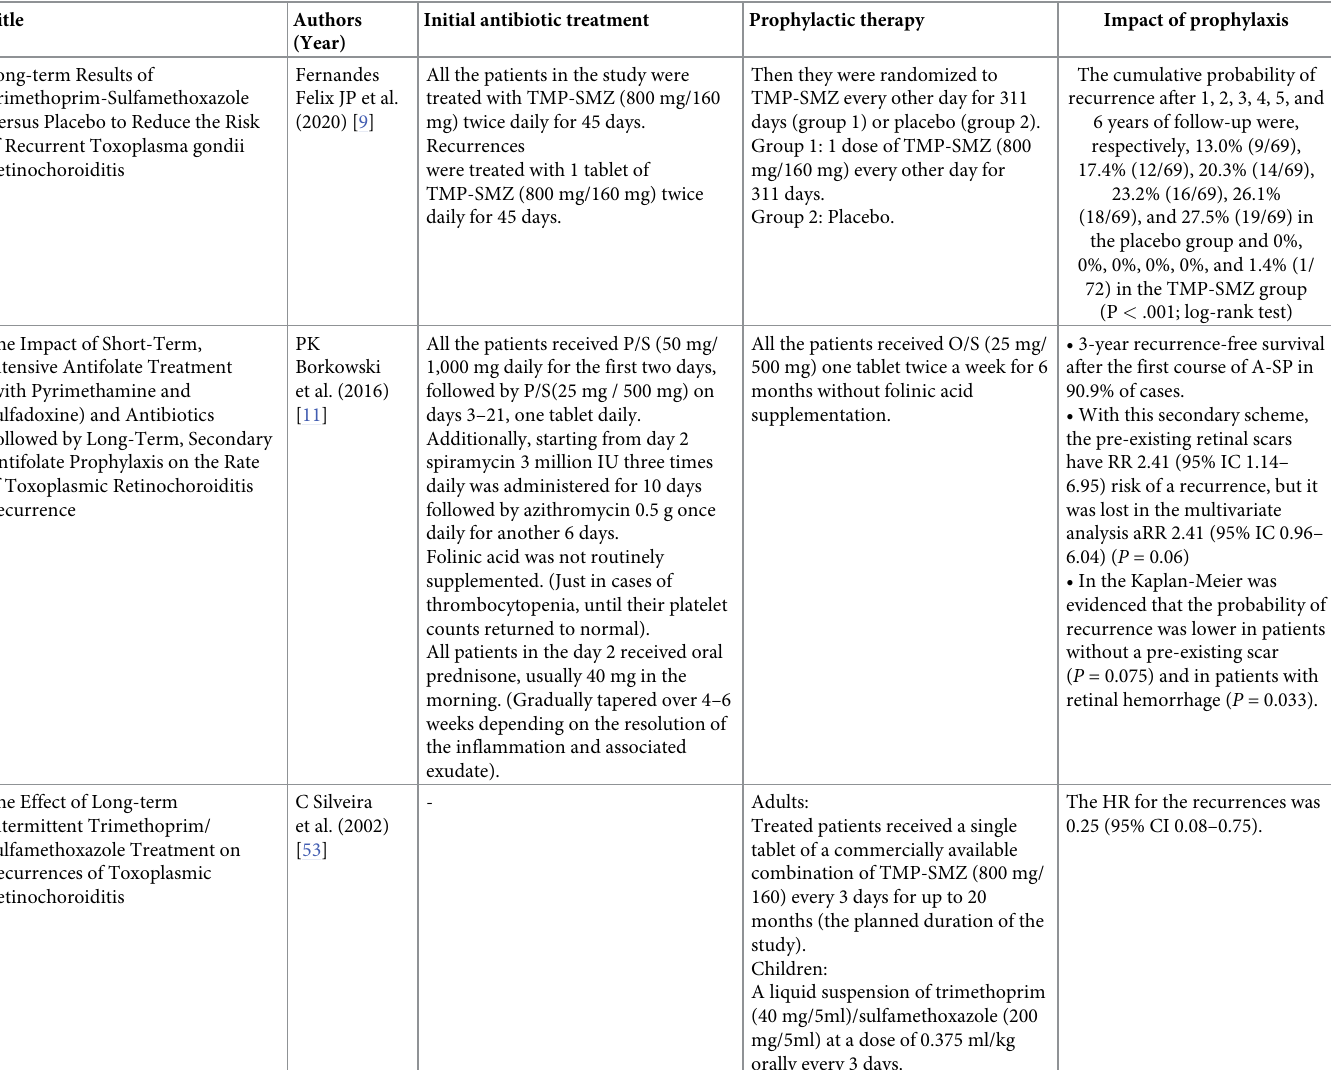
Table 4. Prophylaxis scheme in OT. Prophylactic therapy to avoid recurrences: In patients with OT it refers to an additional scheme of treatment during at least 6 months. However, schemes and times vary between articles [9, 11,